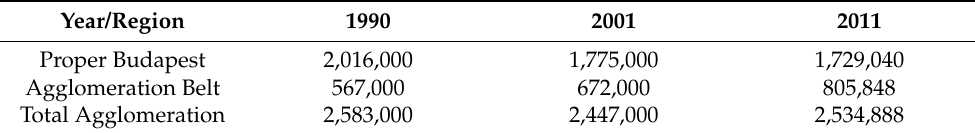
Table 1. Continuous urban sprawl process in Budapest even after the communist